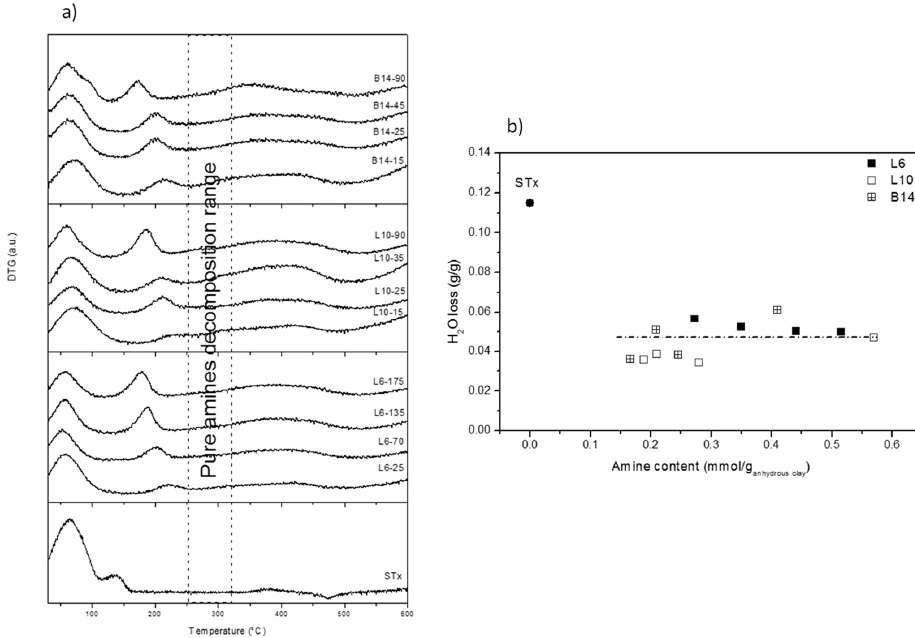
Figure 4. ( a ) DTG curves of pristine and modified-clays prepared at different polyamine content; and ( b ) Water loss (calculated from thermal decomposition) as a function of the amine content for pristine and modified clays .